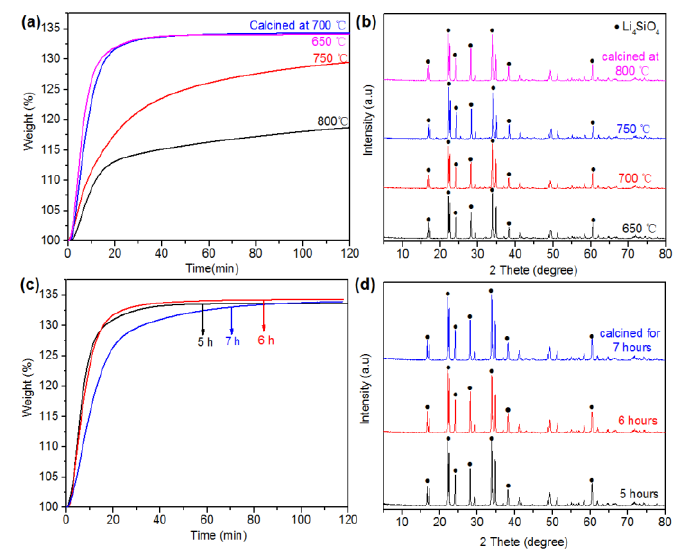
Figure 5. ( a ) The CO 2 sorption performance of Li 4 SiO 4 -(EX-VMT)-4 samples synthesized at different temperatures (CO 2 sorption was evaluated at 650 °C), ( b ) XRD patterns of Li 4 SiO 4 -(EX-VMT)-4 samples synthesized at different temperatures, ( c ) The CO 2 sorption performance of Li 4 SiO 4 -(EX-VMT)-4 samples synthesized at 700 °C for different times (CO 2 sorption was evaluated at 650 °C), and ( d ) XRD patterns of Li 4 SiO 4 -(EX-VMT)-4 samples synthesized at 700 °C for different times.